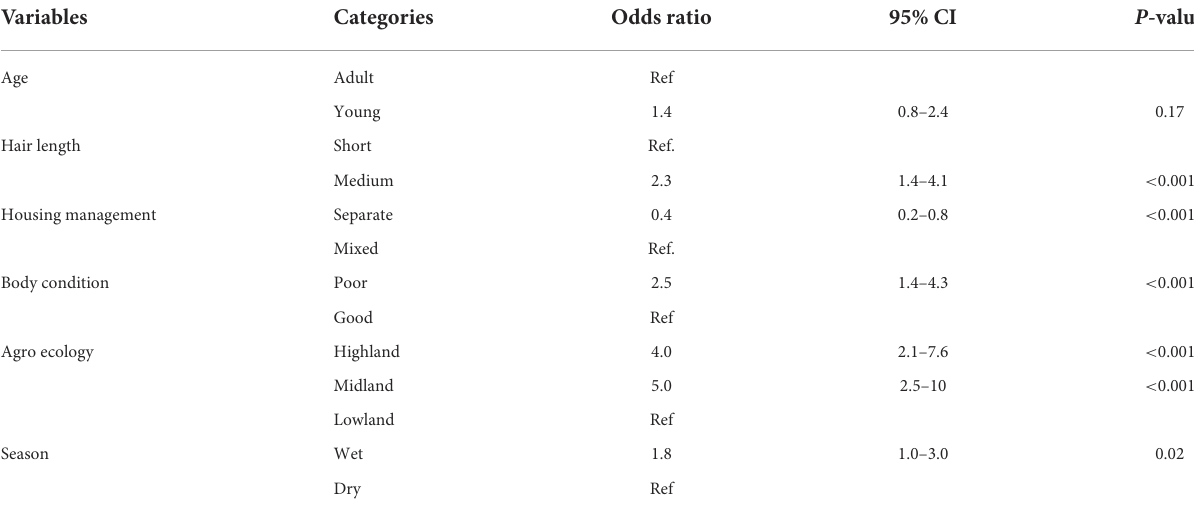
TABLE 3 Univariable logistic regression analyses of risk factors associated with sheep lice infestation in Sayint district, South Wollo, Ethiopia.